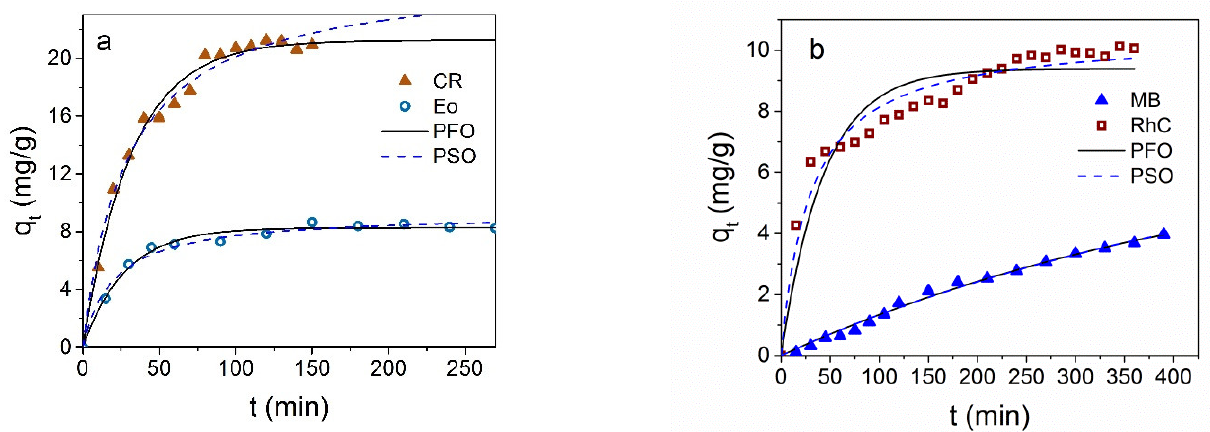
Figure 7. The q t dependence on the Fe 3 O 4 contact time with CR and EoY ( a ), MB, and RhC ( b ). Black solid lines are nonlinear fitting of the results to the pseudo-first-order (PFO) model; dotted lines are the results nonlinear fitting to the pseudo-second-order (PSO) model. Experimental conditions: 25 °C, C 0 = 60 mg/L for CR and C 0 = 30 mg/L for other dyes, m (NPs) ≈ 3 mg in V = 1.5 mL. The q t (t) dependencies are different for different dyes: Fe 3 O 4 NPs adsorb the anionic